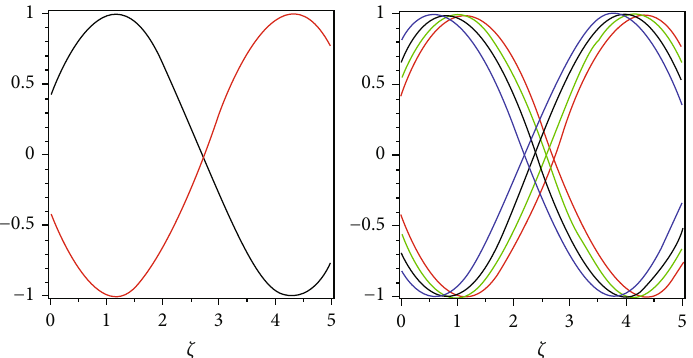
Figure 4: The approximate solution graph of fuzzy upper and lower branches and the 2nd fi gure is the various fractional order of ℘